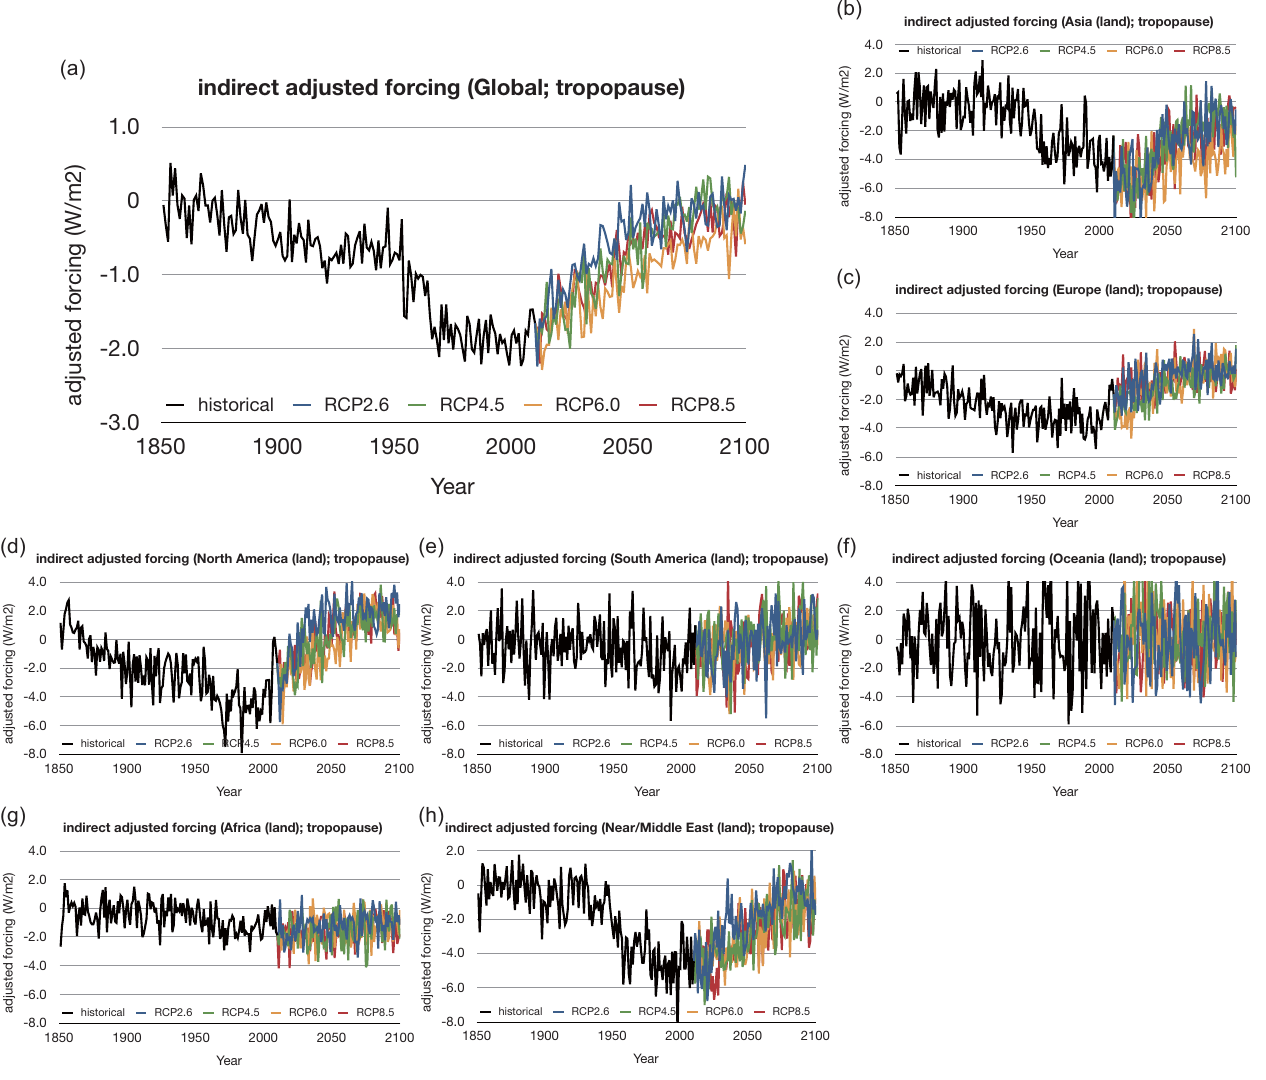
Fig. 14. Time series of changes in annual and (a) global or (b) – (h) regional mean adjusted forcing due to the aerosol indirect effect at the tropopause relative to the preindustrial experiment simulated by SPRINTARS. The regional mean values are only over land. The historical period is shown in black, and the four RCPs are shown in